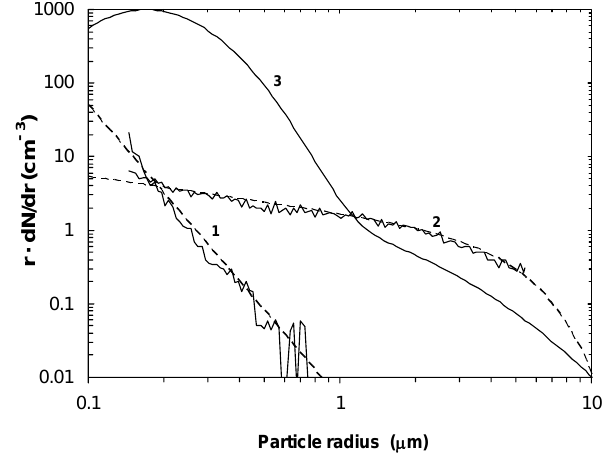
Figure 2. Observed background aerosol particles spectrum in the BCC at a mass concentration of 5 × 10 − 4 mg/m 3 (1), the spectrum of dry salt particles (2) and the spectrum of the South African hygroscopic flares particles (3) both at the same mass concentration 0.4 mg/m 3 . Dashed lines refer to the approximation made by functions (1, 2).